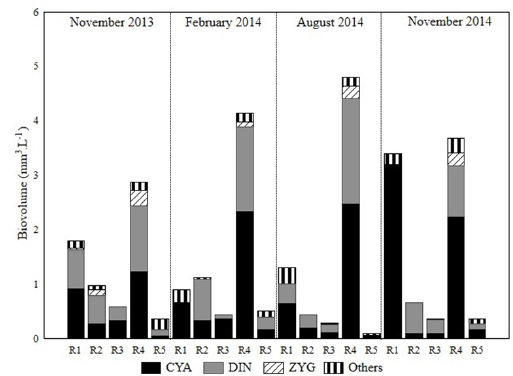
Figure 5. Temporal and spatial distribution of phytoplankton biomass in the reservoirs studied between November 2013 and November 2014 (CYA-Cyanobacteria; DIN-Dinophyceae; ZYG- Zygnematophyceae; Ilha Solteira Reservoir - R1; Jupiá Reservoir - R2; Porto Primavera Reservoir - R3; Três Irmãos Reservoir - R4; Rosana Reservoir -